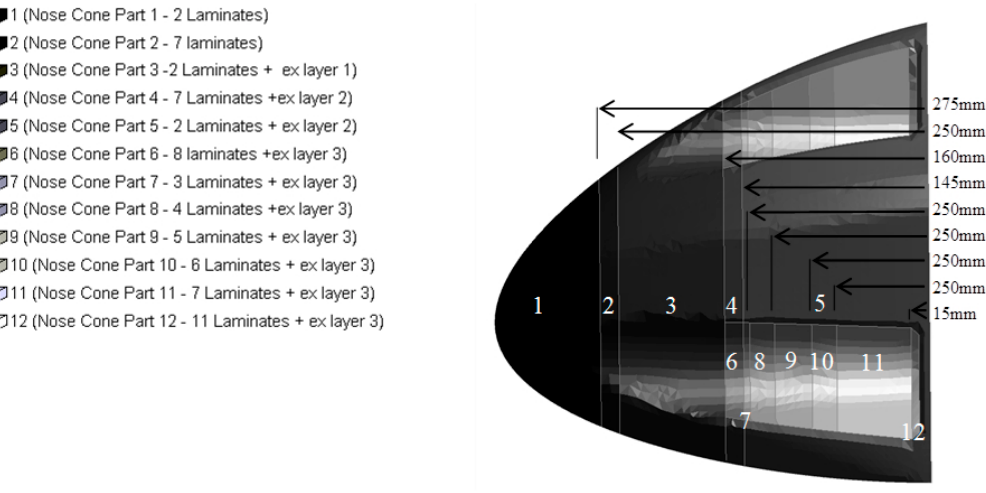
Figure 4. Composite layup of nose cone.